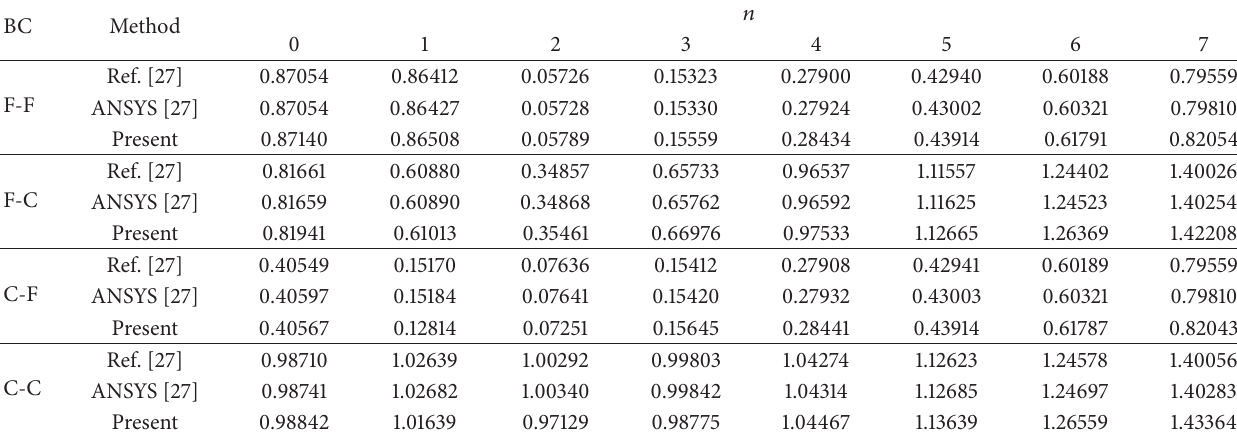
Table 21: Comparison of the frequency parameters Ω = 𝜔𝑅√𝜌(1 − 𝜇 2 )/𝐸 for an annular spherical shell with different boundary conditions ( 𝑚 = 1 ).